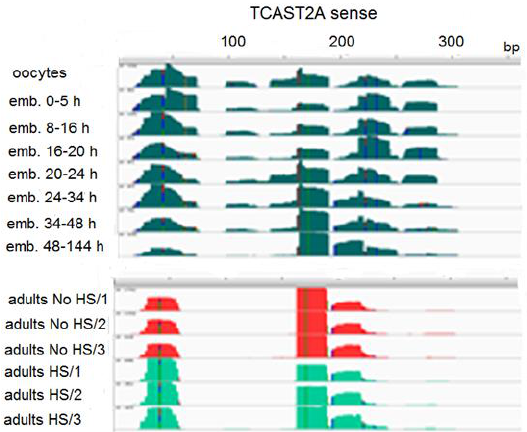
Figure 6. Distribution of TCAST2A piRNA reads along the sense strand of TCAST2A monomer (359 bp) during embryogenesis and in adults kept at normal temperature (No HS; in triplicate), as well as adults subjected to heat stress (HS; in triplicate). 2.4. H3K9me3 Levels at TCAST2 and TCAST1 Repeats after HS A positive correlation between the expression of a major TCAST1 satellite DNA after heat stress and the level of silent histone marks H3K9me3/2 at the TCAST1 satellite DNA repeats was previously reported [22,23]. Here, we analyse H3K9me3 levels at TCAST2 satellite repeats after heat stress relative to a control not subjected to HS, as well as on arrays of TCAST1, which served as a positive control. Chromatin immunoprecipitation (ChIP) using H3K9me3 antibody was performed on chromatin isolated from adult beetles subjected to 24 h of heat stress at 40 °C imme- diately after HS and after 45 min and 90 min of recovery at 25 °C, respectively, as well as on chromatin from control beetles. The level of H3K9me3 was quantified by qPCR using primers specific for TCAST2 and TCAST1 repeats, respectively. The results reveal no statistically significant change ( p > 0.05) of H3K9me3 level at TCAST2 repeats at any point after HS relative to the control, while the level of H3K9me3 at TCAST1 repeats was in- creased 2.9x ( p = 0.003), 2.6x ( p = 0.002) and 1.9x ( p = 0.004), respectively, immediately af- ter HS, at 45 min and 90 min of recovery (Figure 7). The results support a model accord- ing to which the transient increase of satellite transcripts after HS leads to the transient enrichment of silent histone marks at homologous satellite arrays. In the case of the TCAST2 satellite, HS does not significantly induce satellite expression and consequently the level of H3K9me3 remains unchanged.